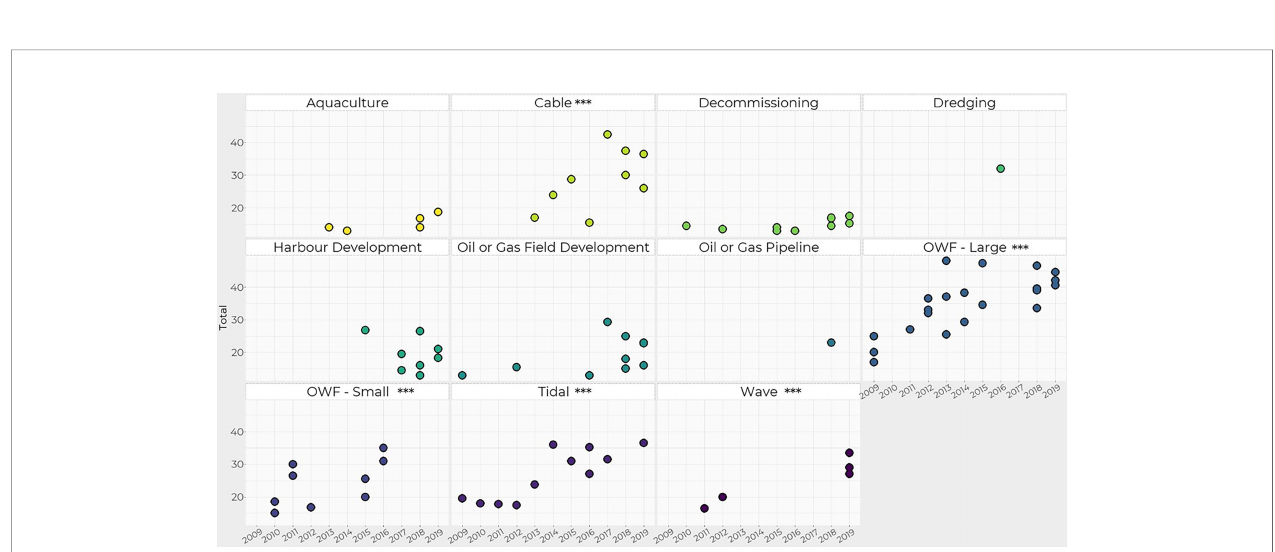
FIGURE 3 | Total score of each Cumulative Effects Assessment (CEA) over the 10-year study period, by maritime industry. Asterisks*** next to industry name are displayed where change over time was signi fi cant, indicated by a multiple linear regression model, where p =